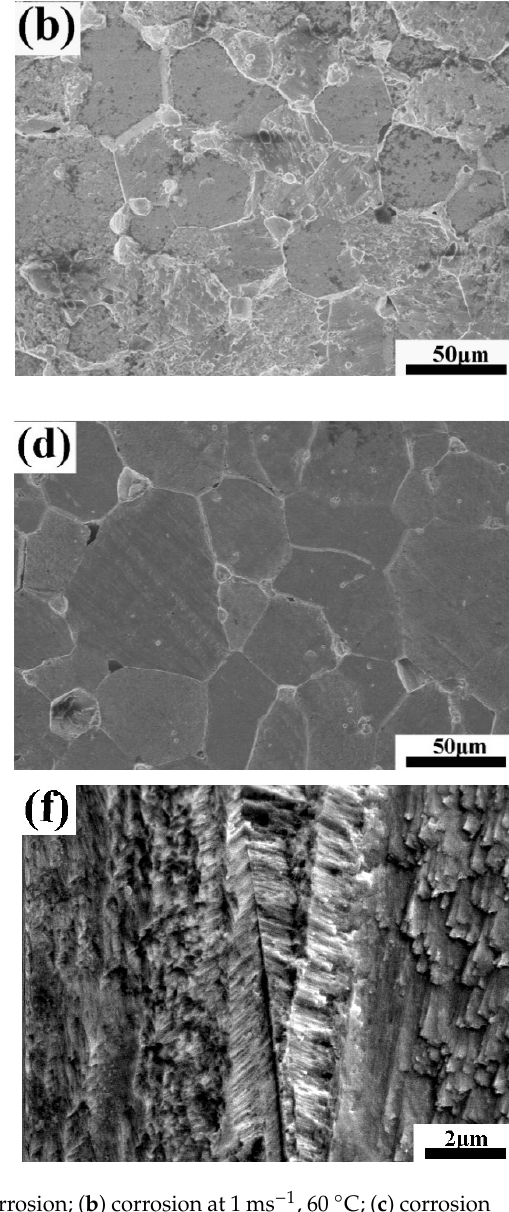
Figure 6. SEM images of bare tungsten: ( a ) before corrosion; ( b ) corrosion at 1 ms −1 , 60 °C; ( c ) corrosion at 1.5 ms −1 , 60 °C; ( d ) corrosion at 2 ms −1 , 60 °C; ( e ) corrosion at 2 ms −1 , 20 °C; and ( f ) corrosion on grains.